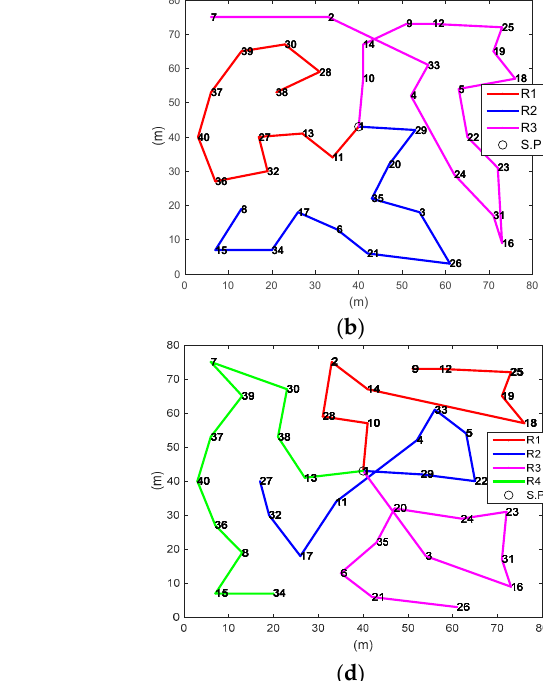
Figure 11. Multirobot optimal task allocation diagram from Experiment 2: ( a ) algorithm in this paper ( m = 40, n = 3); ( b ) basic genetic algorithm ( m = 40, n = 3); ( c ) algorithm in this paper ( m = 40, n = 4); ( d ) basic genetic algorithm ( m = 40, n =